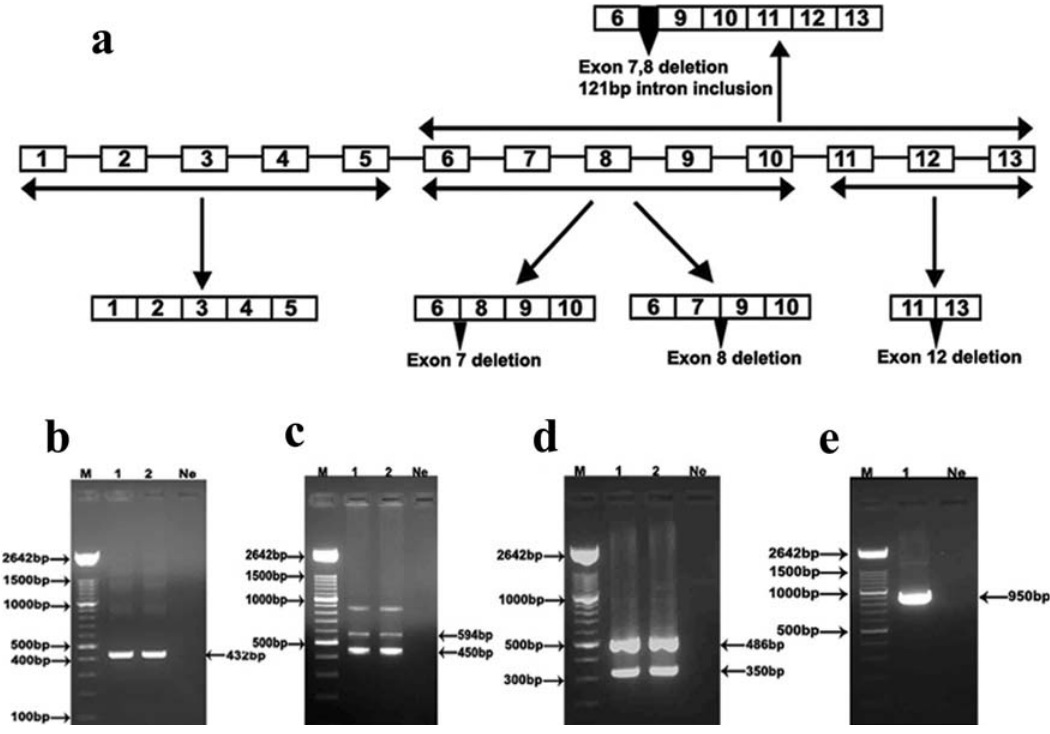
Figure 8. Amplification of exonic regions of the ORF of CYP3A43 and CYP3A4 mRNA by RT-PCR. (a) The schematic representation of 13 exons of CYP3A43 along with their splice variants detected by RT-PCR is depicted. (b) A 432bp amplicon was amplified spanning the exons 1–5 (lanes 1 and 2). (c) Two amplicons (594bp and 450bp) were generated when exons 6–10 were amplified (lanes 1 and 2). The 594bp product was the expected amplicon while the other amplicon (450bp) was a mixture of two PCR products of which one had a deletion of exon 7 and other had a deletion of exon 8. (d) Amplification of the region spanning exons 11–13 gave two amplicons of sizes 486bp and 350bp. The 486bp product was the expected size while 350bp product represented a splice variant that had the deletion of exon 12. (e) Amplification of exons 6–13 generated an amplicon (950bp) representing a splice variant having deletion of both exon 7 and 8 and partial inclusion of 121bp intron 7.